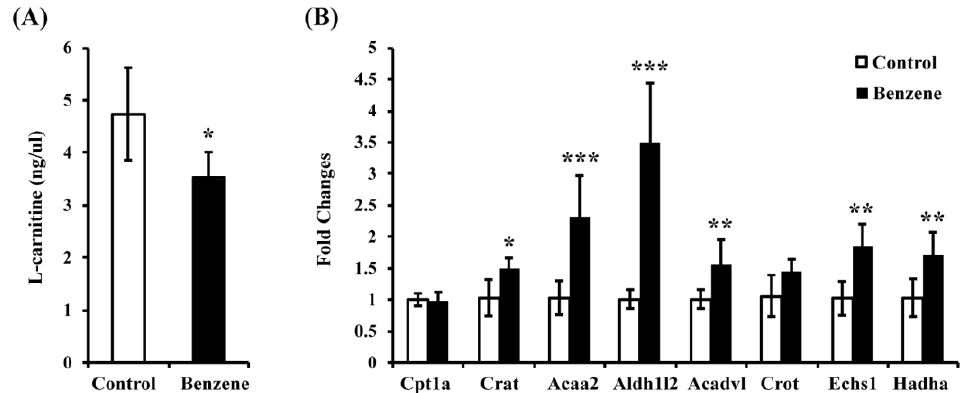
Figure 2. Benzene induces reduced l-carnitine and alters expression of key genes in the fatty acid β-oxidation (FAO) pathway in mouse bone marrow (BM) cells. ( A ) l-carnitine level in control and benzene group; ( B ) FAO-related gene expression in two groups. Values are mean ± SD; Compared